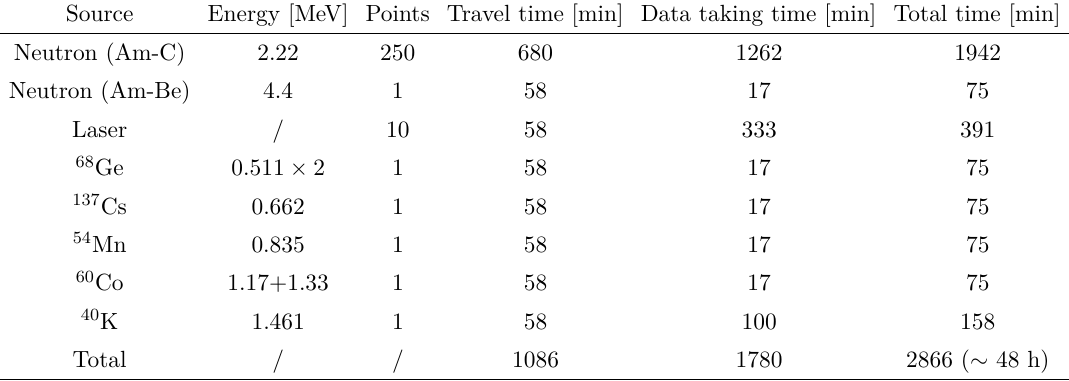
Table 5 . A baseline plan of a comprehensive calibration. The AmC will be deployed into 250 points utilizing the ACU, CLS and GT. All other sources will rely on the ACU only. More sources at other locations are also possible.